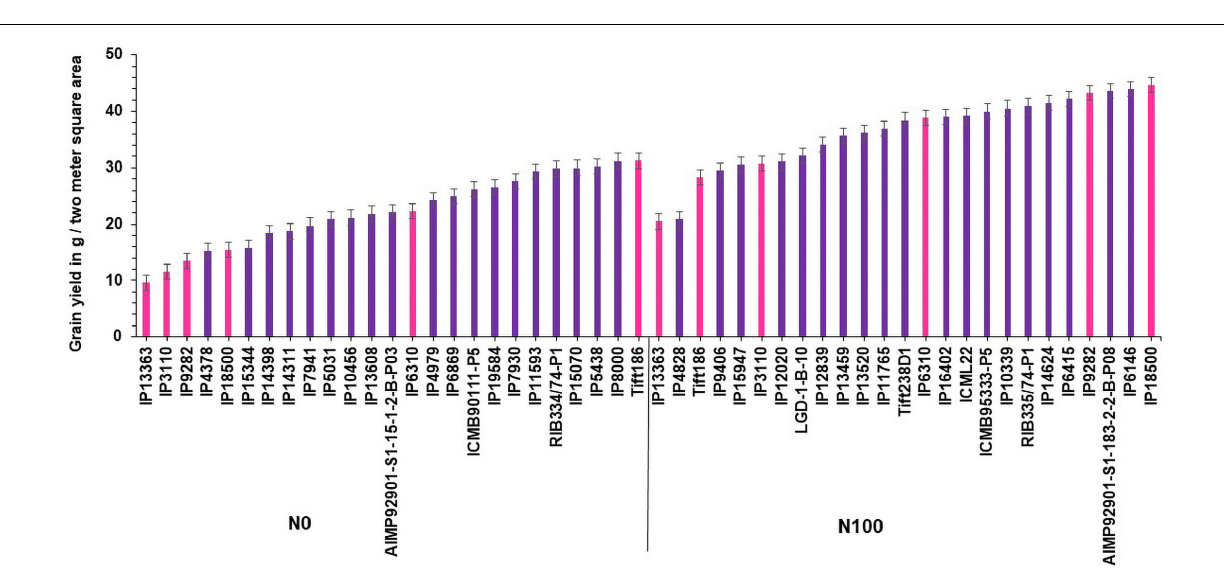
FIGURE 2 | Top 25 poor yielding genotypes for grain yield under N 0 and N 100